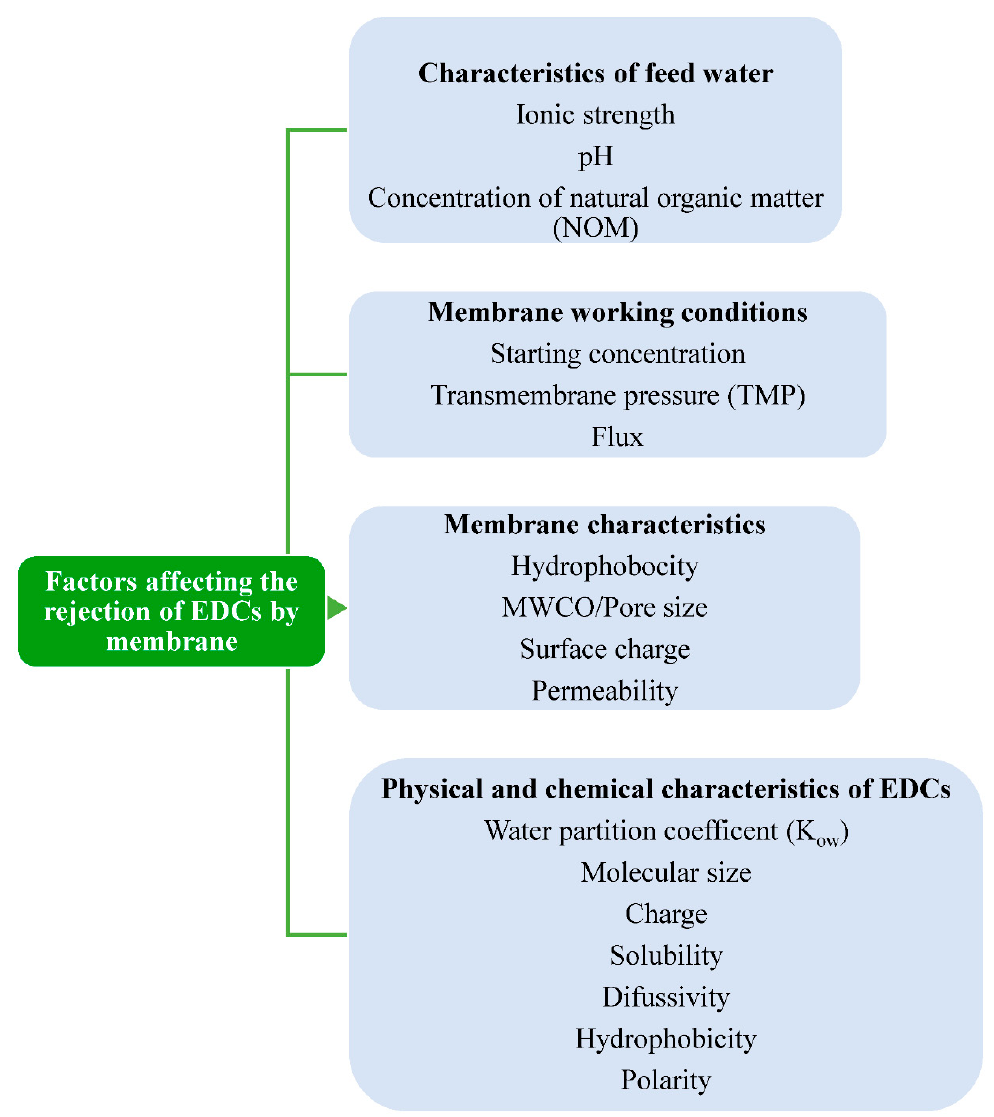
Figure 4. Essential Factors that influence EDCs removal during membrane process. Adapted with modification [123].